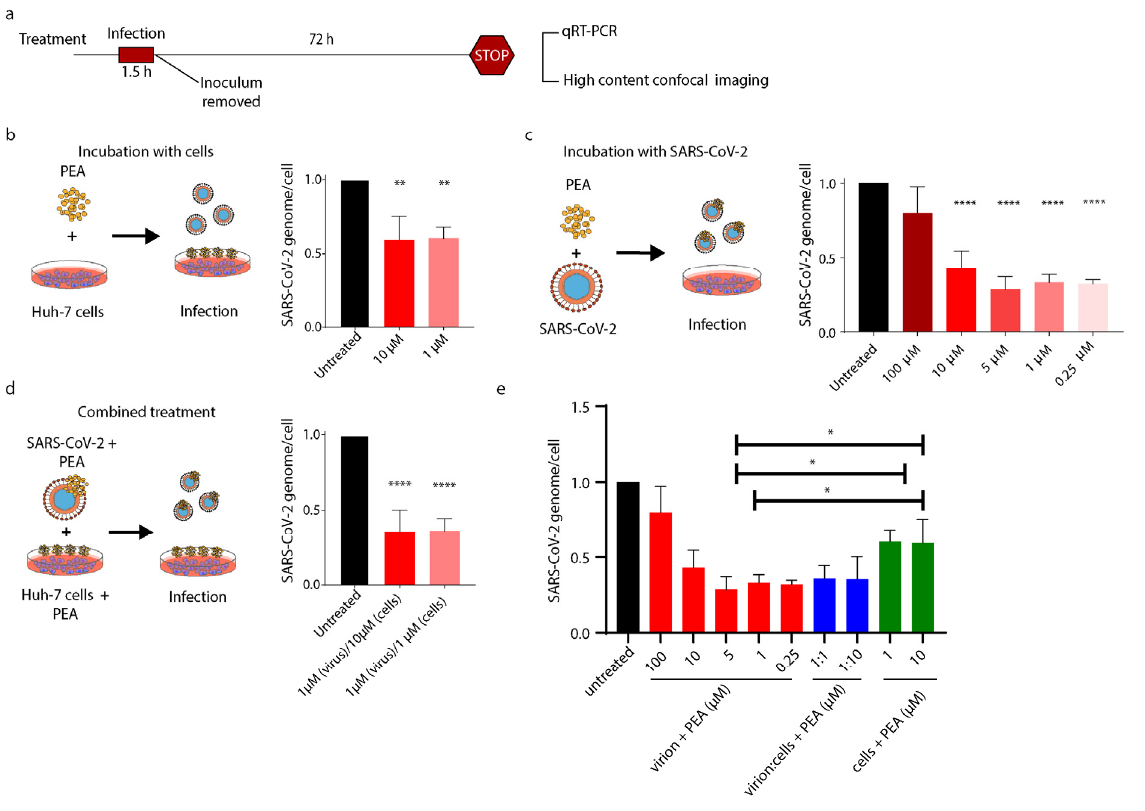
Figure 5. PEA decreases entry of SARS-CoV-2. ( a ) Schematic illustration of experimental workflow and PEA treatment. ( b ) SARS-CoV-2 genome’s relative quantity in cells treated or not with PEA after infection. ( c ) SARS-CoV-2 genome’s relative quantity in cells infected with PEA-preincubated SARS-CoV-2 virions. ( d ) SARS-CoV-2 genome’s relative quantity in cells treated with a combination of previous treatments. ( e ) SARS-CoV-2 genome’s relative quantity in cells treated as described in b, c, and d. Data were normalized on β -actin content in cell lysates. Data are expressed as means ± SD and were analyzed using a one-way ANOVA (n = 3, * p < 0.5, ** p < 0.01; **** p < 0.0001).